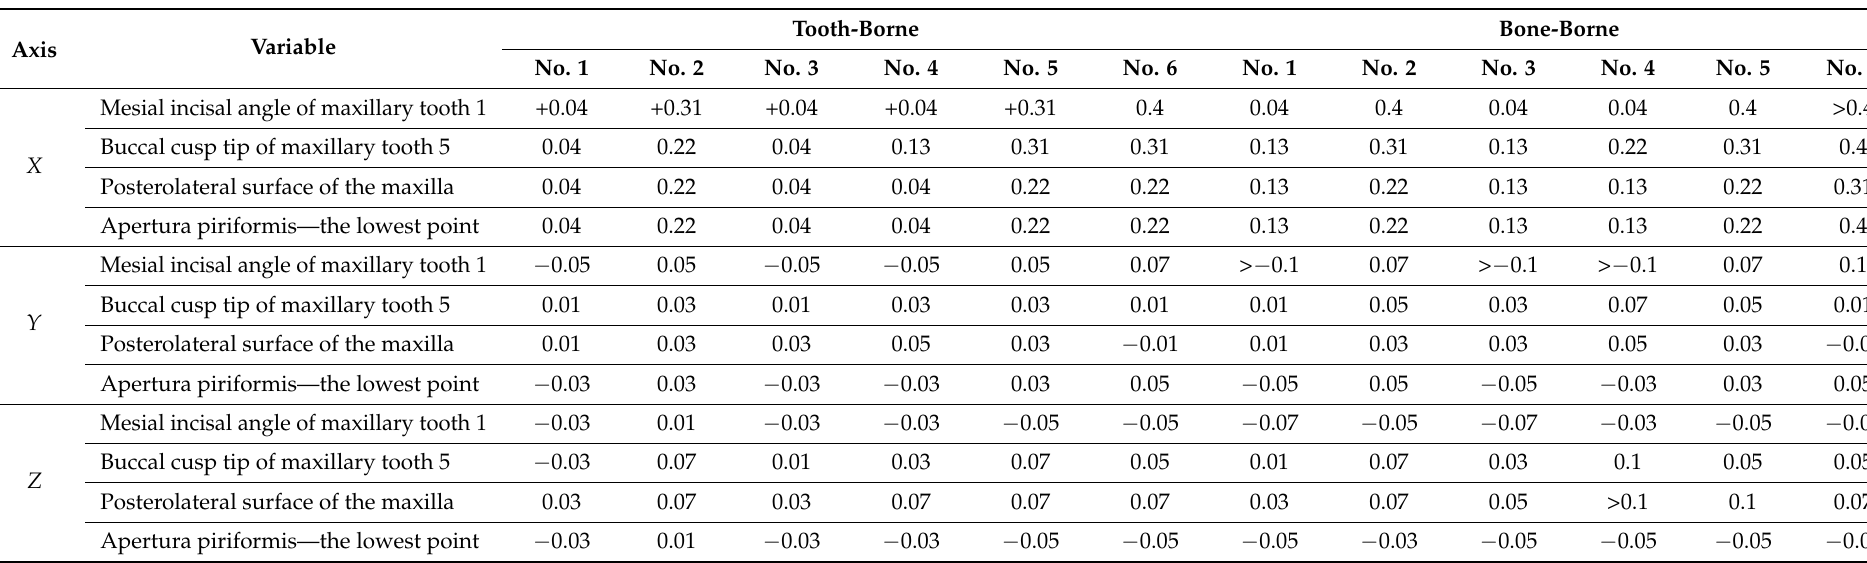
Table 4. Displacement values of selected anatomical structures (mm) along the X , Y and Z -axes, with various surgical procedures and the tooth-borne and bone-borne appliance using finite element analysis. Tooth-Borne Axis Variable